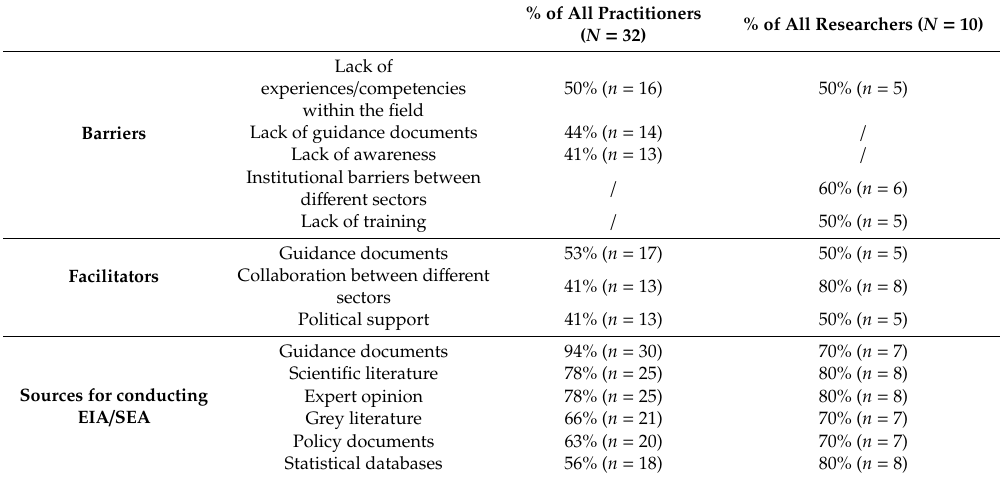
Table 5. The table lists the three main barriers and facilitators to include health into EIA / SEA for practitioners and researchers, as well as sources used to conduct EIA / SEA by practitioners and researchers. The percentages (%) are calculated using the frequency of the answer (n) and dividing it through the total number of cases